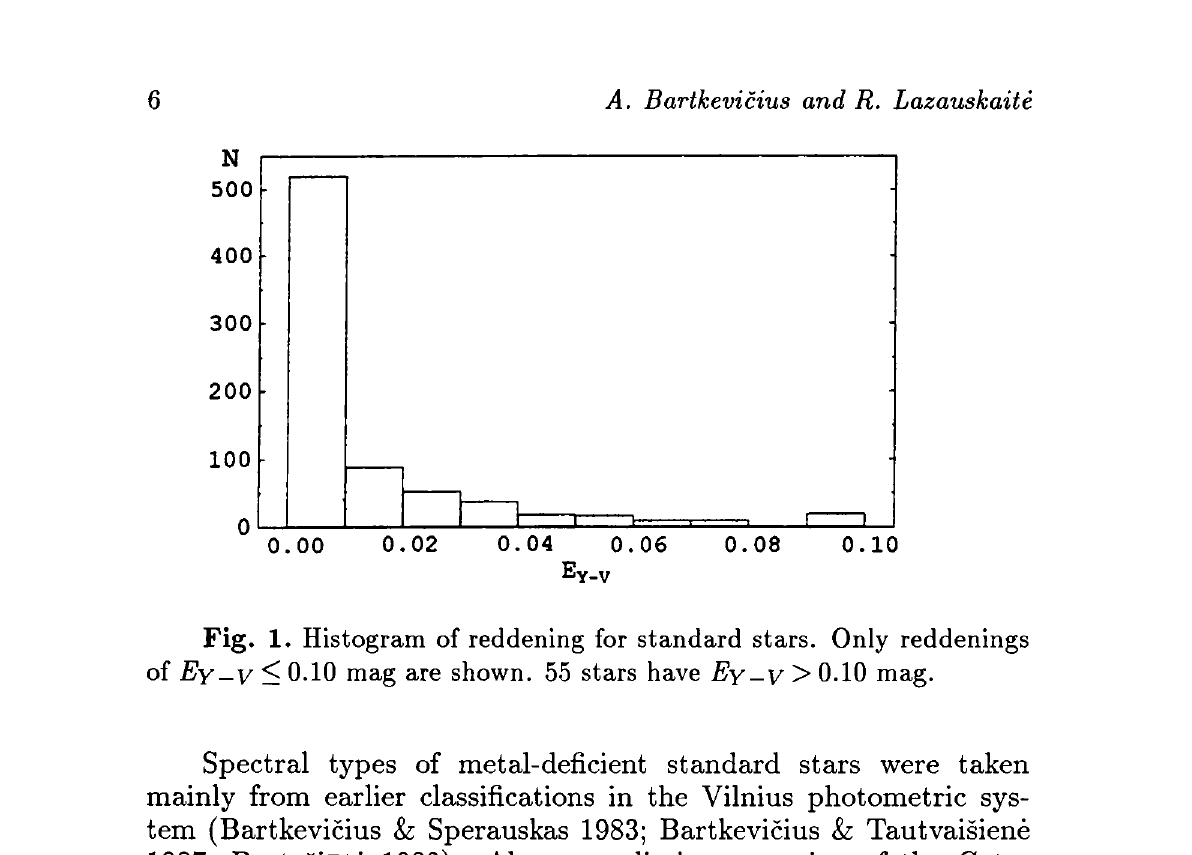
Fig. 1. Histogram of reddening for standard stars. Only reddenings of Ey~v < 0.10 mag are shown. 55 stars have Ey-V > 0.10